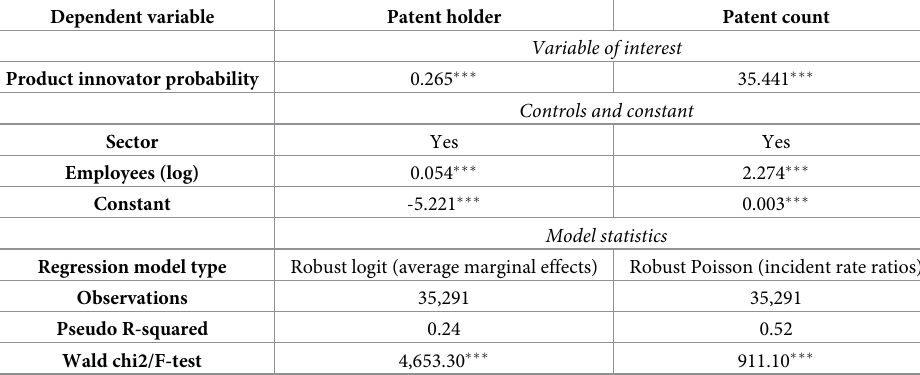
Table 3. Firm-level patent statistics regression